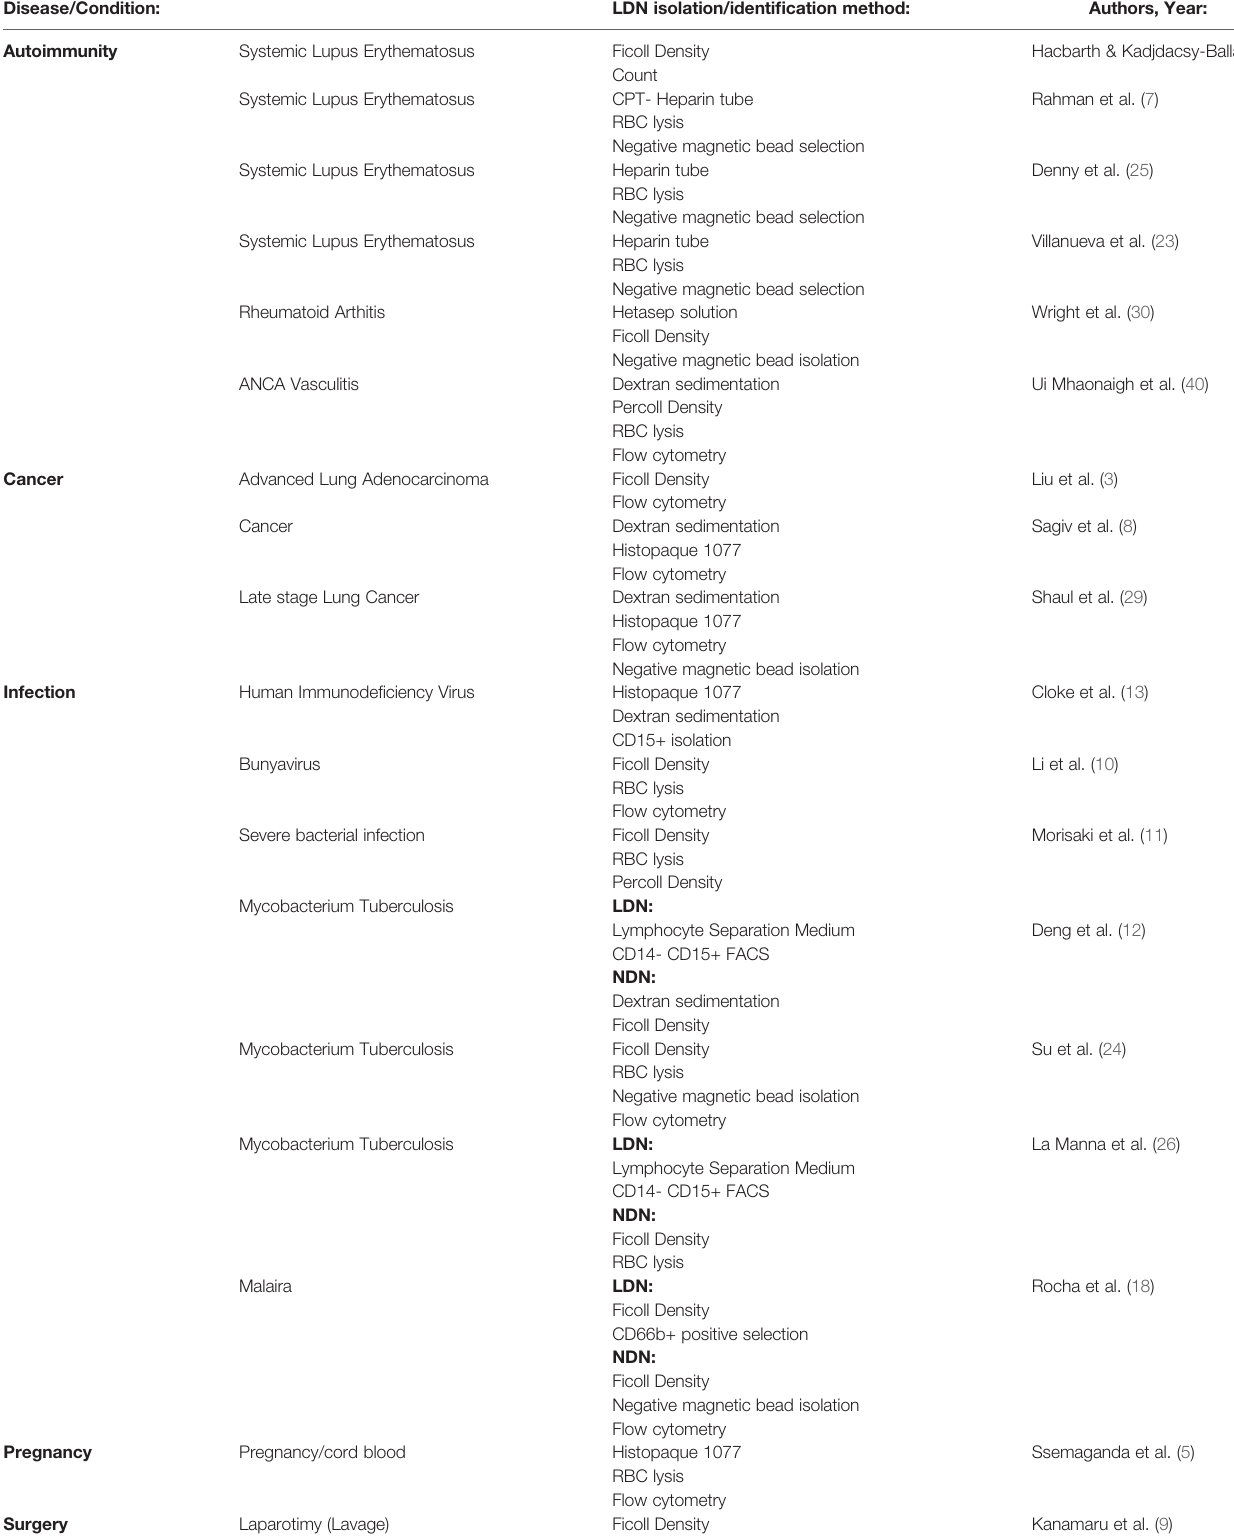
TABLE 3 | Overview of LDN population isolation and identi fi cation.